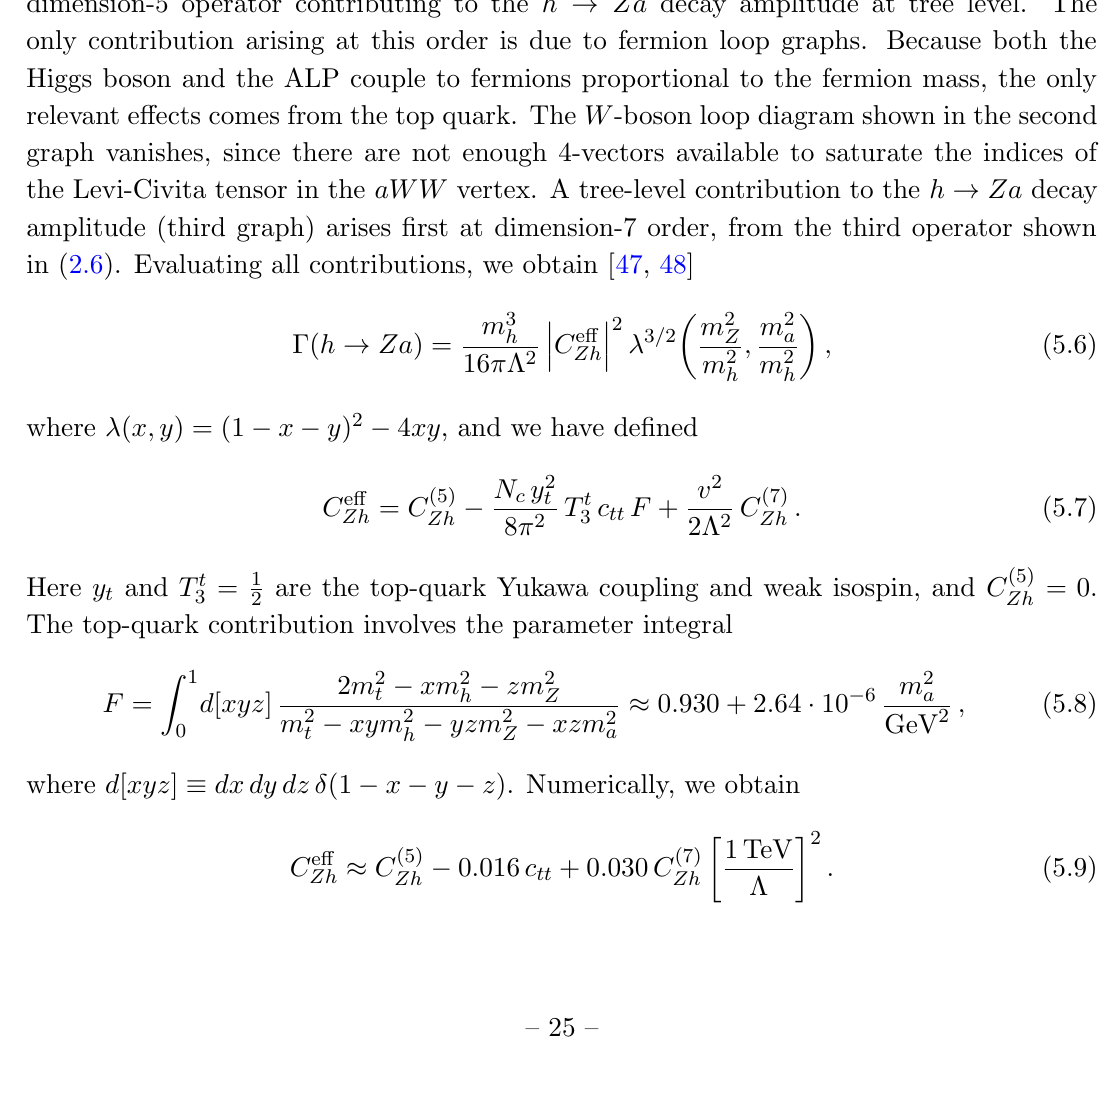
Figure 9 . E(cid:11)ective h Za ‘ + ‘ (cid:0) (cid:13)(cid:13) branching ratio as a function of the ALP mass for a (cid:12)xed ! ! value Br( h Za ) = 0 : 1 at m a = 1 GeV. The solid lines refer to a 100% a ! along with C e(cid:11) = (cid:3) = 1 = TeV (blue) and C e(cid:11) = (cid:3) = 0 : 1 = TeV (red). The dotted lines are obtained (cid:13)(cid:13) j (cid:13)(cid:13) j j j by lowering the a (cid:13)(cid:13) branching ratio to !